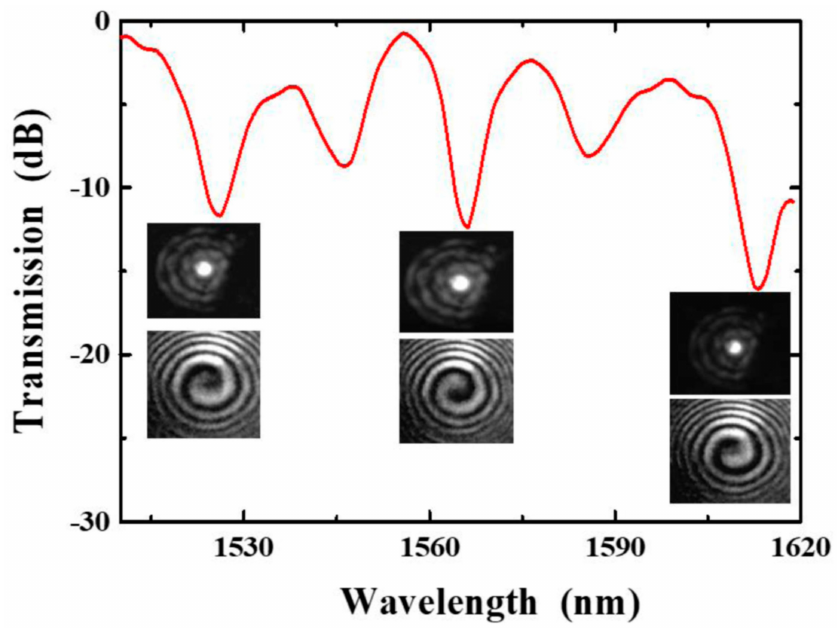
Figure 37. The spectrum, the corresponding intensity, and phase distributions of the OAM modes generated at three channels of the HLPG simultaneously. Adapted with permission from ref. [178]. © [2022] IEEE.